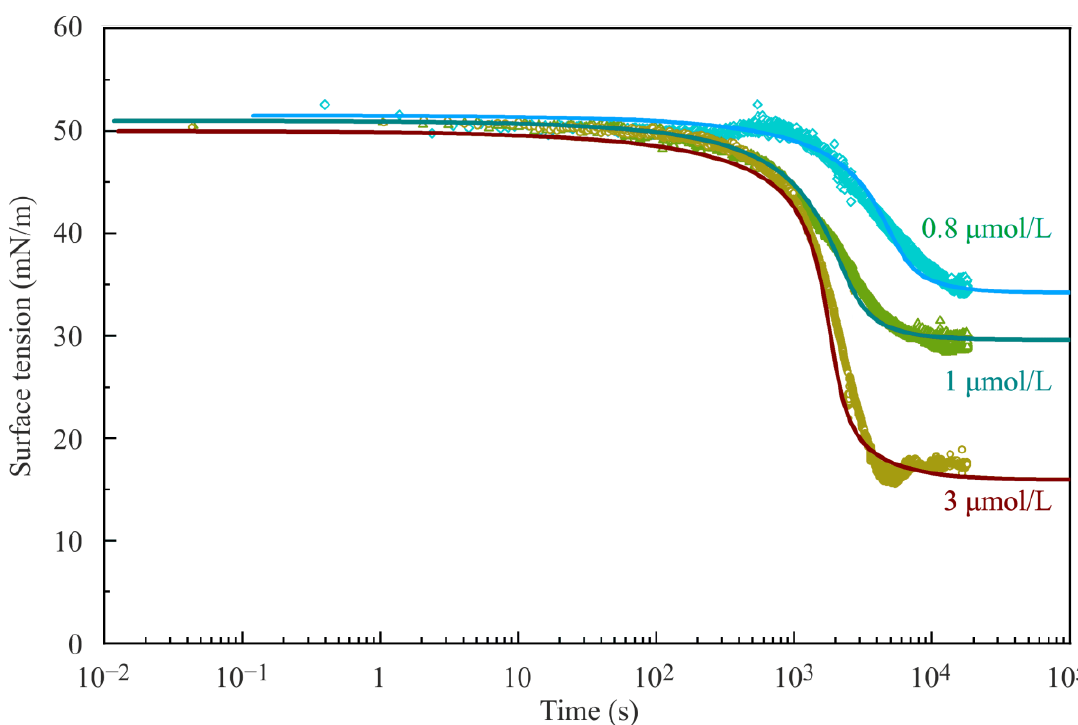
Figure 8. Dynamic interfacial tension of mixed aqueous solutions of NaC 12 SO 4 + C 16 TAB at the water/hexane interface measured by PAT-1; ( (cid:7) ) 0.8 µ mol/L, ( ) 1 µ mol/L, ( • ) 3 µ mol/L; solid lines are calculated from the Frumkin adsorption model; the same data and the corresponding fitted curves for the reorientation model are shown in the supplement materials.